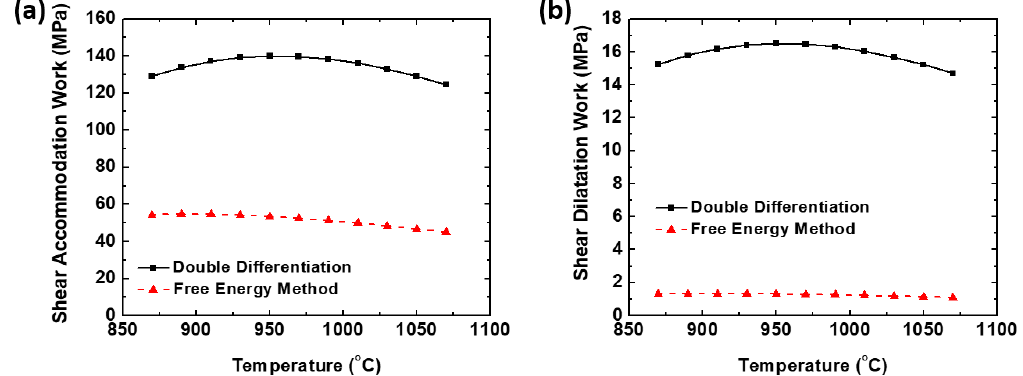
Figure 5. The calculated ( a ) shear accommodation and ( b ) dilatation work based on the critical stresses of Figure 4.